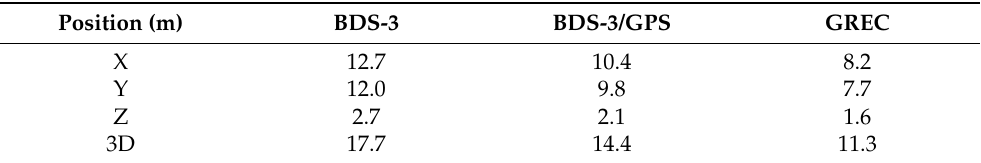
Table 9. RMS of Position with different system combinations.